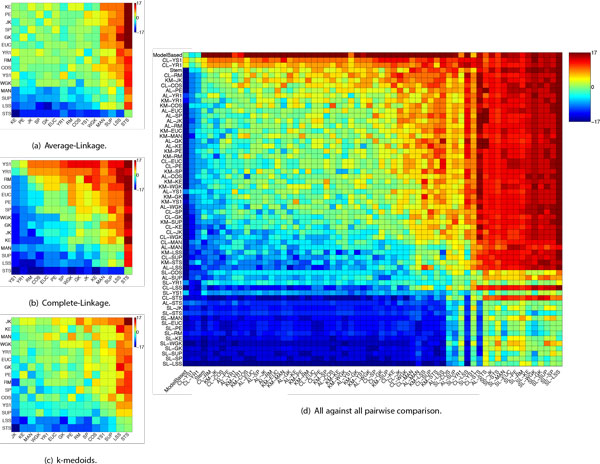
Gene Time-Series Results: Results for gene time-series data. Figures (a), (b) and (c) depict pairwise comparison of distances for each clustering method. Figure (d) depicts an all against all pairwise comparison. Each cell account for the number of datasets in which the method from the row obtained a better enrichment than the method from the column. The "hotter"/"colder" the cell the better/worst is the row method in comparison to the column one.